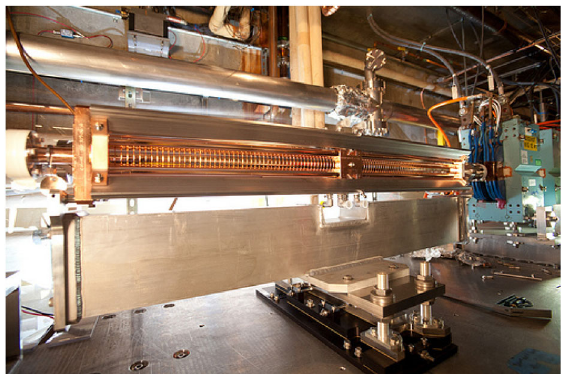
FIG. 13. The 1-m-long X -band deflector installed in the FACET beam